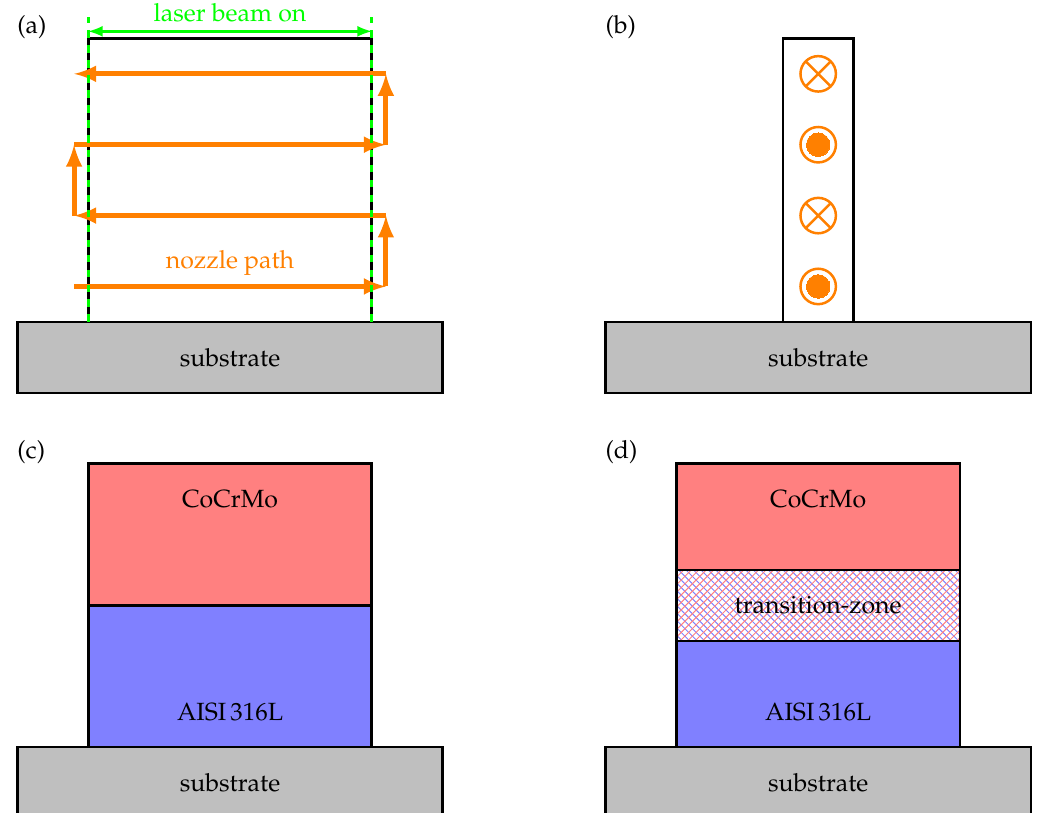
Figure 2. Schematic introducing the bi-directional scanning strategy and the different structures manufactured by laser- based DED, where arrows indicate the feed motion. ( a ) side view, ( b ) front view, ( c ) sharp transition, ( d ) smooth